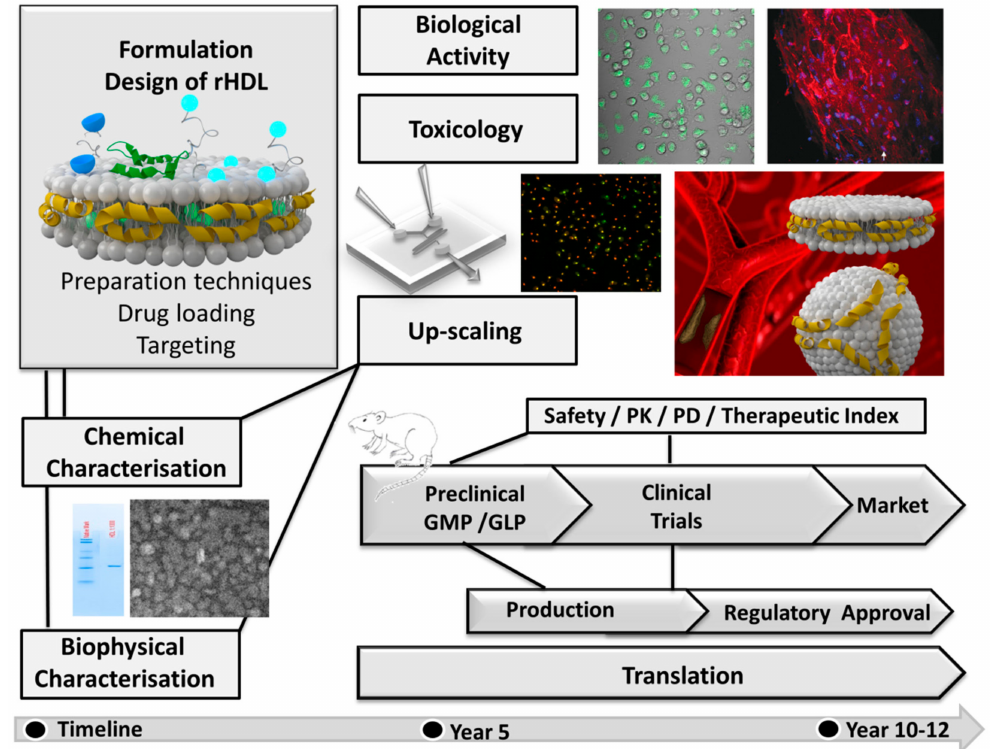
Figure 7. Simplified scheme showing a tentative time frame for the development of rHDL based drug delivery systems depicting the steps involved in translational research from bench to